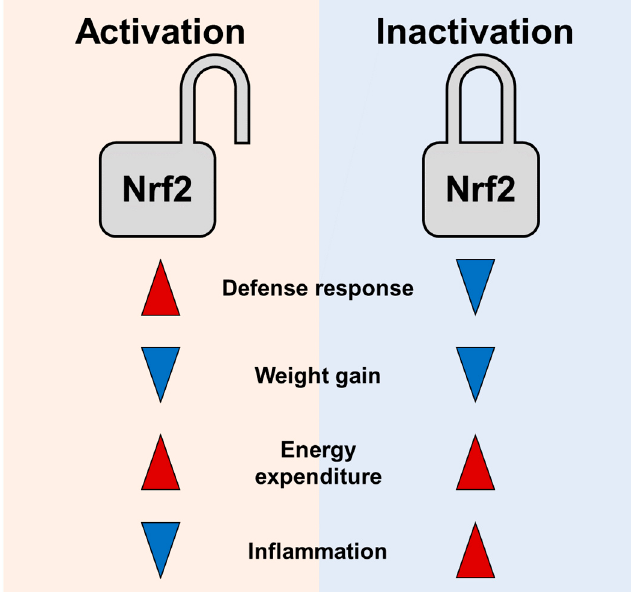
Figure 2. Comparative effects of Nrf2 activation and Nrf2 inhibition on defense responses, weight reduction, and increases of energy expenditure. Schematic diagram shows effects of Nrf2—gain and loss—of function on energy expenditure and weight reduction. Various cellular stresses can activate Nrf2 to provide defense mechanisms in antioxidation and detoxification. Nrf2 inhibition increases energy expenditure and decreases weight gain in a high calorie diet feeding. However, Nrf2 inhibition potentially fails to protect cells from oxidative/electrophilic stress and inflammatory insults. By contrast, chemical Nrf2 activators can stimulate mitochondrial biogenesis in tissues while Nrf2 inhibition impairs mitochondrial biogenesis and energy expenditure.